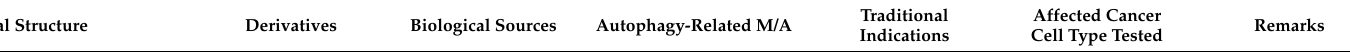
Table 1. Examples of natural materials that modulate autophagy, including chemical structure.